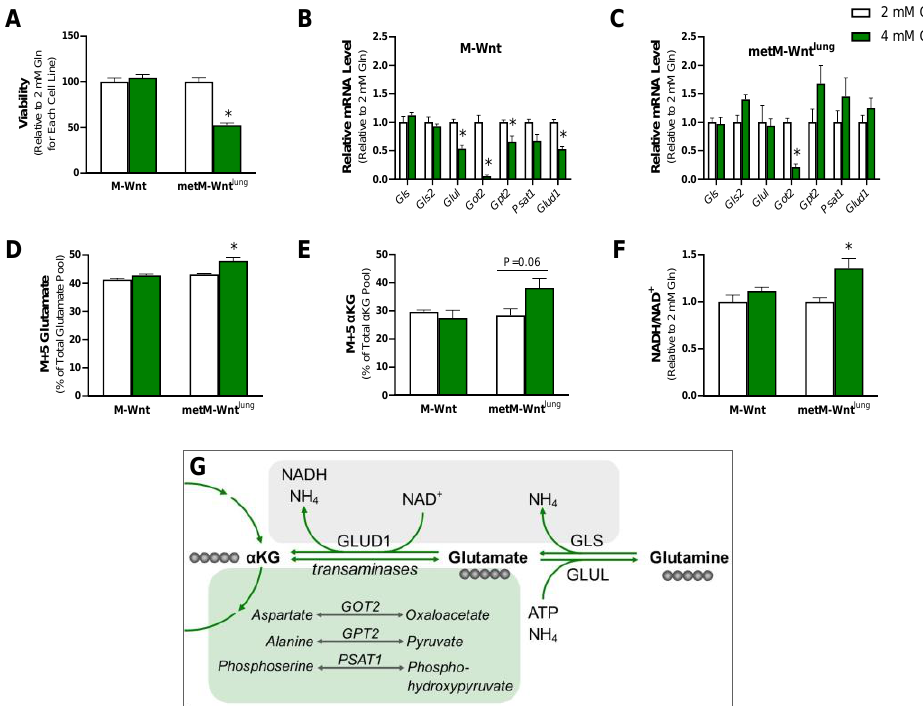
Figure 1. Effect of glutamine concentration on glutamine metabolism. ( A ) Viability of M-Wnt and metM-Wnt lung cells maintained in 2 mM or 4 mM glutamine was assessed by MTT; ( B , C ) mRNA level of genes involved in glutamine metabolism in M-Wnt and metM-Wnt lung cells was determined; ( D , E ) labeled 13 C 5 -labeled glutamine was used to determine labeling of the downstream metabolites glutamate and α -ketoglutarate; ( F ) NADH/NAD + ratios were measured. Overview of glutamine catabolism ( G ). Abbreviations: GLS — glutaminase; GLUL — glutamine synthetase; GLUD1 — glutamate dehydrogenase; GOT2 — glutamic oxaloacetic transaminase; GPT2 — glutamic pyruvic transaminase; PSAT1 — phosphoserine aminotransferase 1. The green box highlights transaminase reactions that are coupled with the conversion of glutamate to αKG; the grey box highlights ammonium-producing reactions. Grey circles indicate 13 C labeled carbons in each metabolite if derived from exogenous universally labeled 13 C glutamine. Results are expressed as means + SEM. Asterisk (*) indicates p < 0.05 relative to 2 mM glutamine.